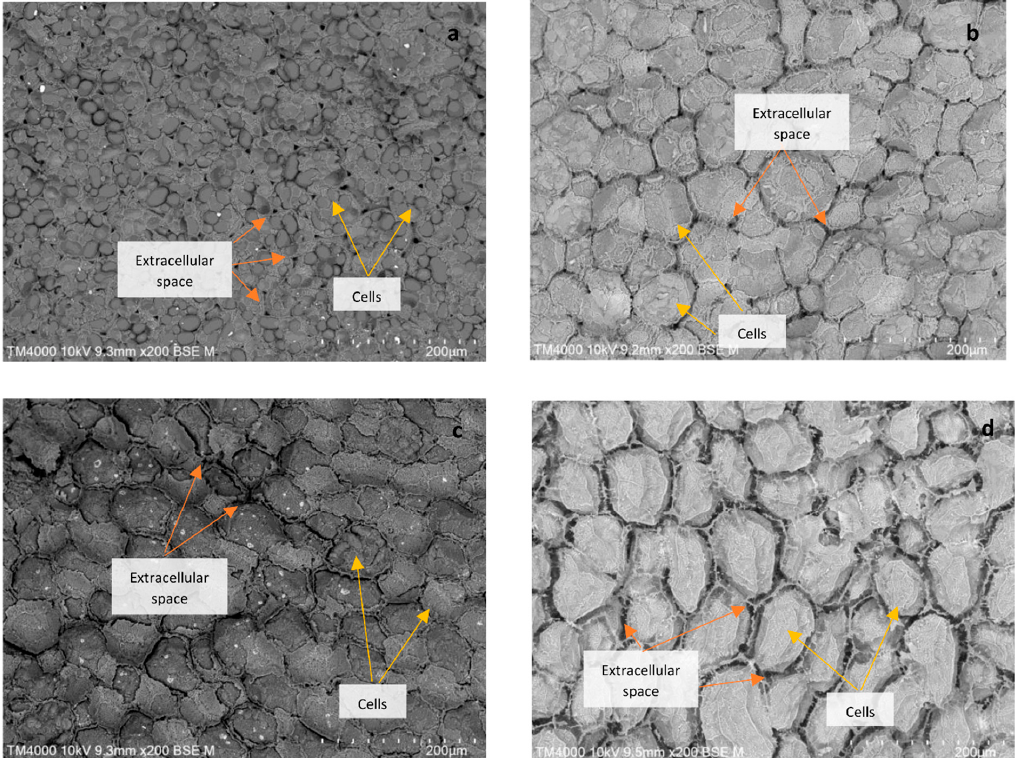
Figure 1. SEM micrographs of fresh ( a ), air-dried ( b ), vacuum-dried ( c ) and freeze-dried ( d ) beans. Scale bar: 200 μ m.